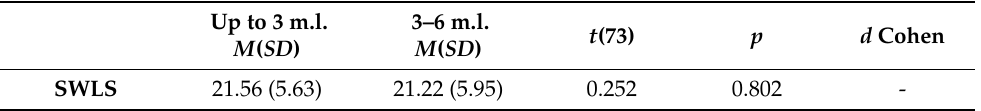
Table 5. The differences between men in terms of life satisfaction taking into consideration the age of a